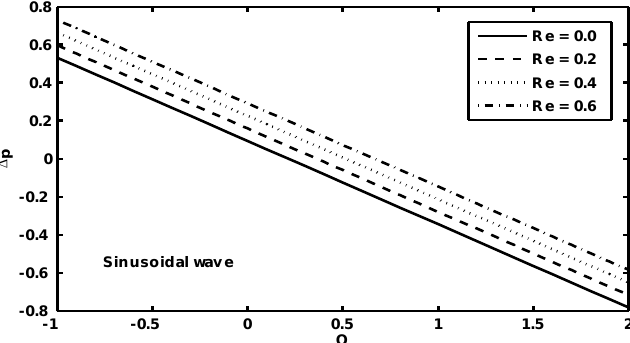
π = 0.4, η = 0.5, λ = 0.1. , Fr = 0.6, η 4 2 1 1